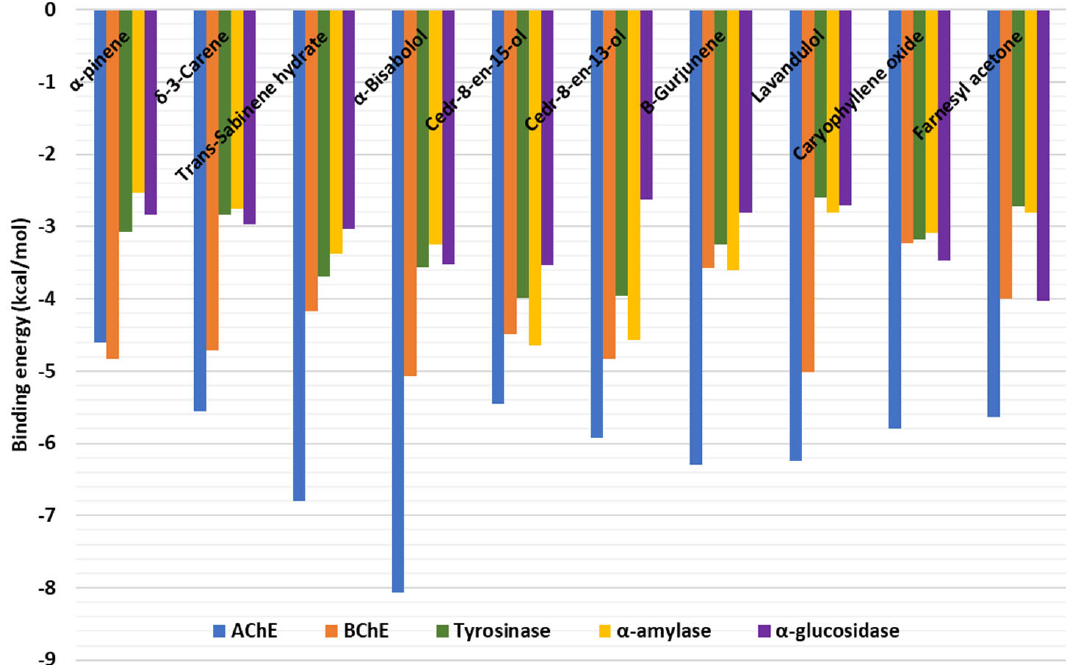
Figure 4. Binding energy (docking) scores of phytochemicals extracted from Chamaecyparis obtusa, Chrysopogon nigritanus and Lavandula coronopifolia .